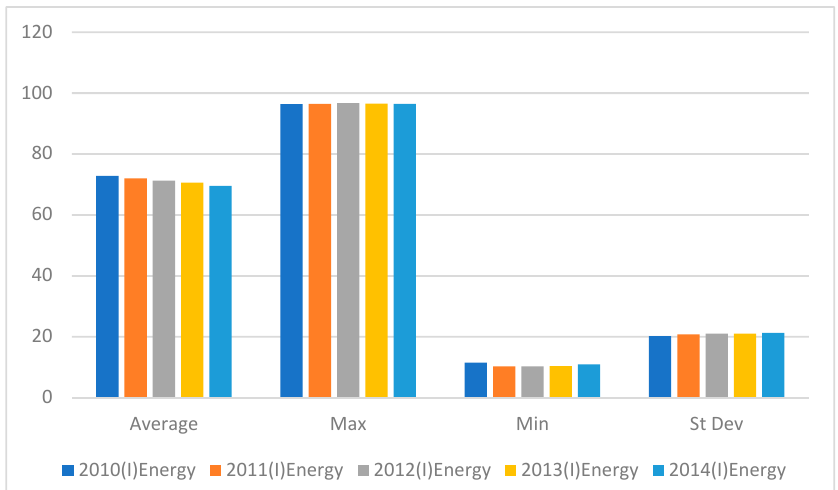
Figure 2. Fixed asset Input variables from 2010–2014.